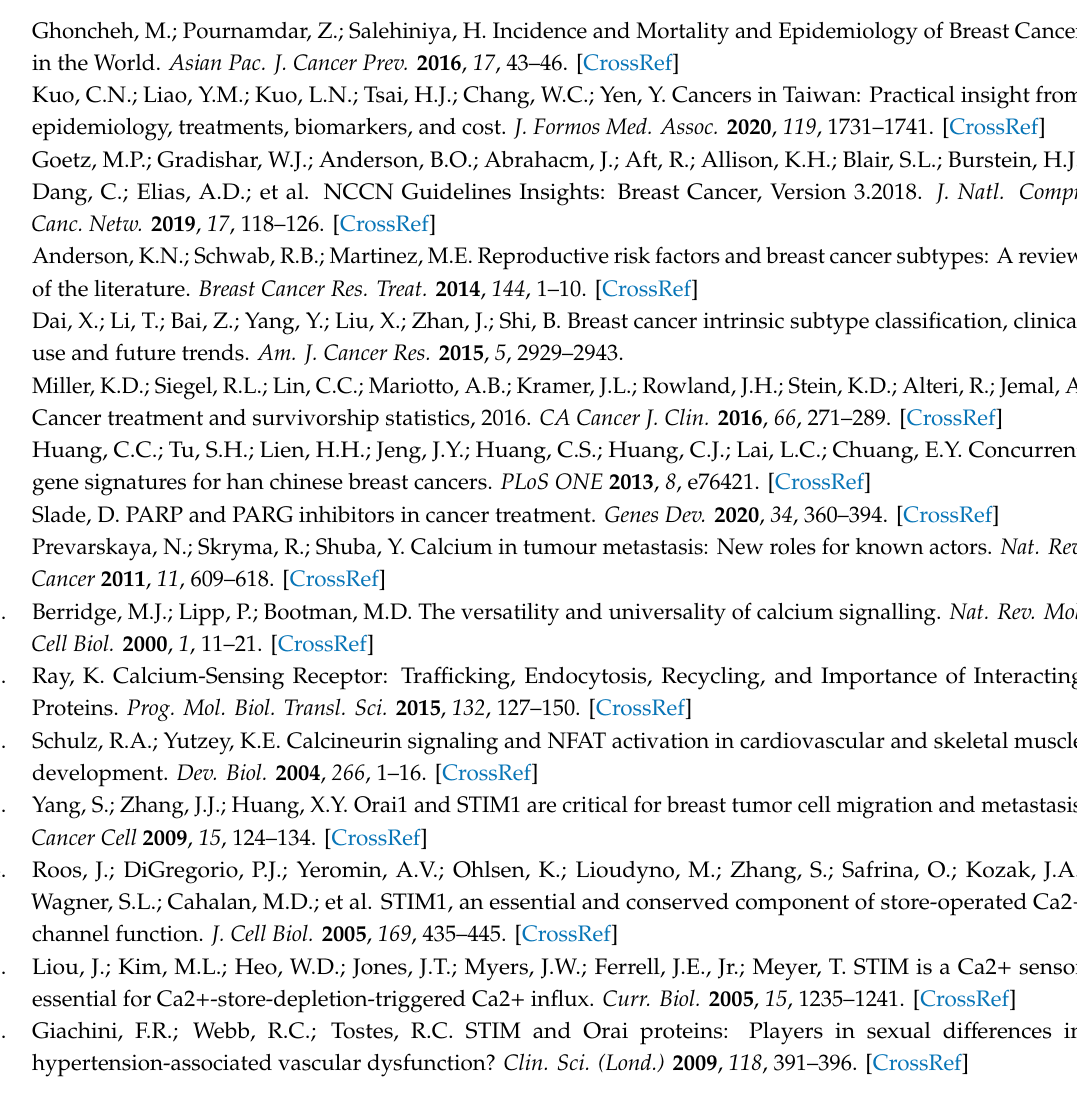
Table S1: Association analysis between genetic polymorphisms of STIM1 and TNM stage in progesterone receptor (PR) positive breast cancer patients, Table S2: Association analysis between genetic polymorphisms of STIM1 and TNM stage in human epidermal growth factor receptor 2 (HER2) positive breast cancer patients, Table S3: Expression quantitative trait locus (eQTL) analysis of STIM1 SNVs, Figure S1: STIM1 gene expression among di ff erent genotypes of rs2304891 in (A) nerve-tibial tissue and (B) heart-left ventricle